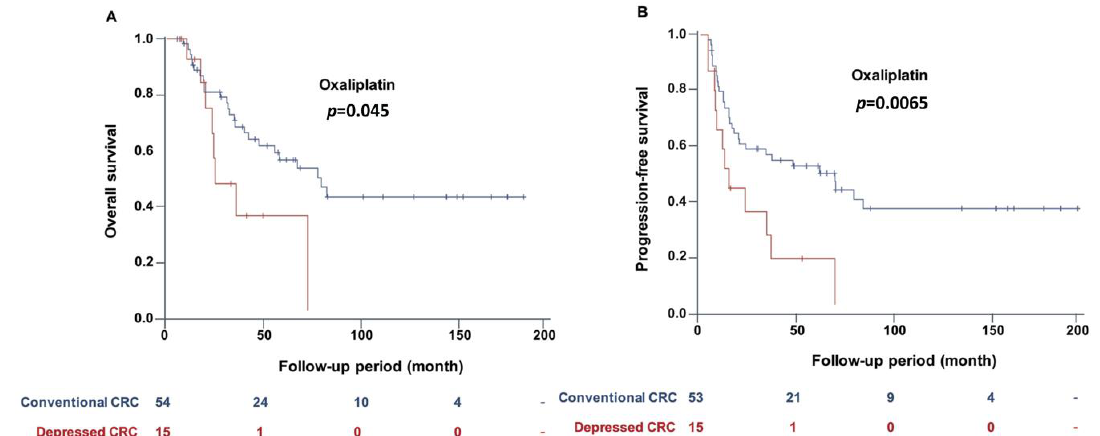
Figure 3. Comparison of progression-free survival (PFS) among depressed CRCs with various genetic changes. Depressed CRC has an unfavorable PFS compared to conventional CRC. The survival deteriorates further if KRAS or BRAF mutation presents, as well as if the CRC is CIMP-positive. D (−): conventional CRC; D(+): depressed CRC; CIMP(+): CIMP-positivity.